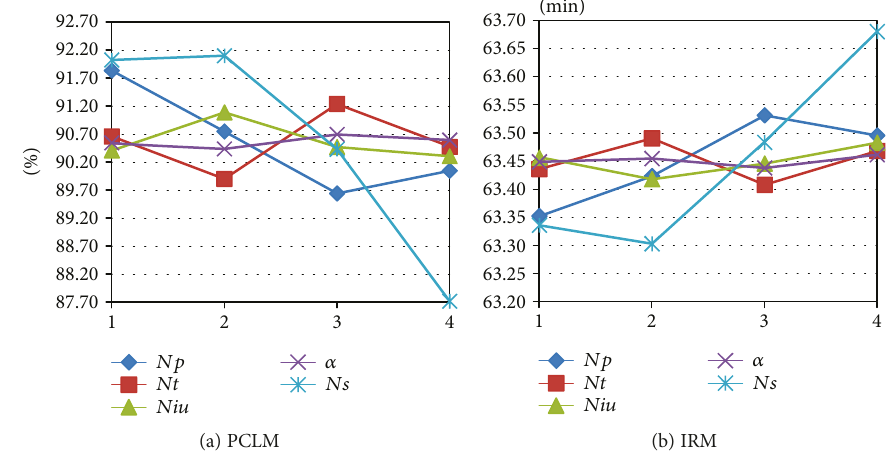
Figure 11: In fl uence of the parameters on the robust objectives under distribution level